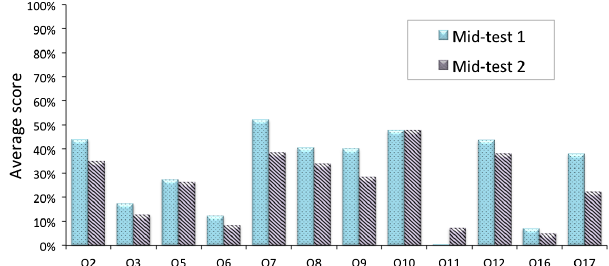
FIG. 12. Comparison of students ’ average scores between the first (blue dotted pattern) and second (purple hatched pattern) CUE midtests ( N ¼ 57